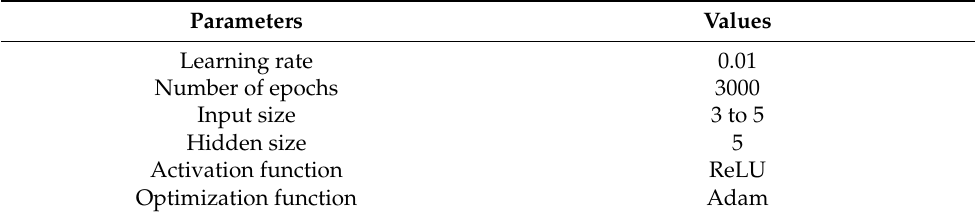
Table 1. The parameters for LSTM